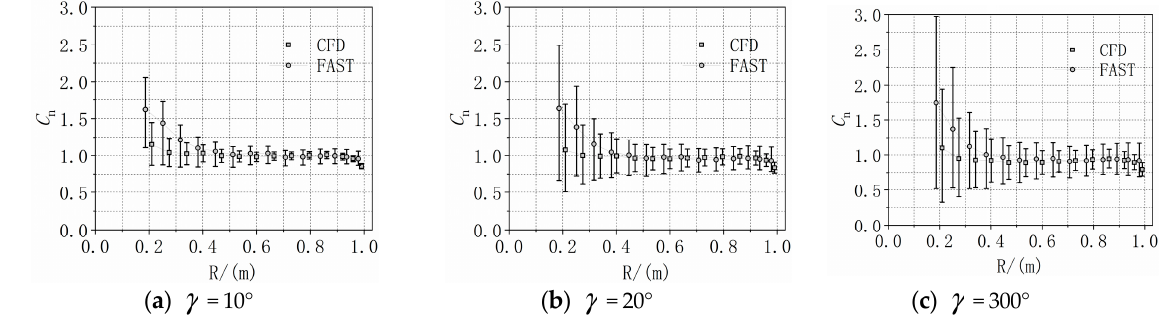
Figure 10. The profile of C n along the blade span under yawed cases.